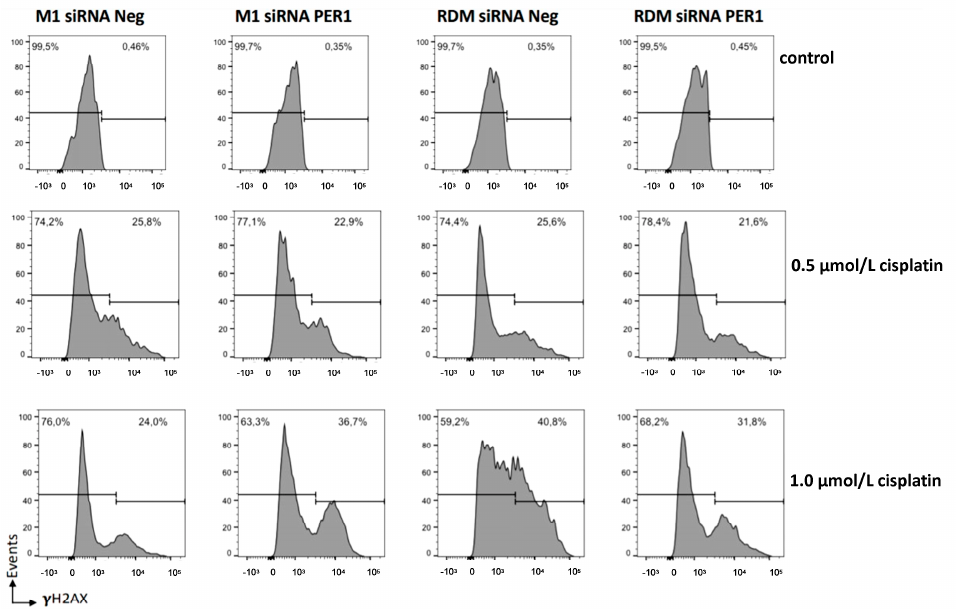
Figure 6. Flow cytometry detection of DNA damage. To evaluate DNA damage, we used the H2A.X phosphorylation assay, a cell-based assay using flow cytometry detection of levels of phosphorylated histone H2A.X on serine 139 ( γ -H2AX), formed in response to DNA double-strand breaks (DSBs) generated by exogenous genotoxic agents. Cells for each condition were treated in vitro with 0, 0.5, and 1 µ mol/L cisplatin for 72 h. See the Materials and Methods section for more details. RDM siRNA NEG = siRNA scramble-treated HepG2 cells; RDM siRNA PER1 = siRNA PER1-treated HepG2 cells; M1 siRNAneg = siRNA scramble-treated macroH2A1 knocked down HepG2 cells; M1 siRNA PER1 = siRNA PER1-treated macroH2A1 knocked down HepG2 cells; three biological replicates were each assayed in triplicate.